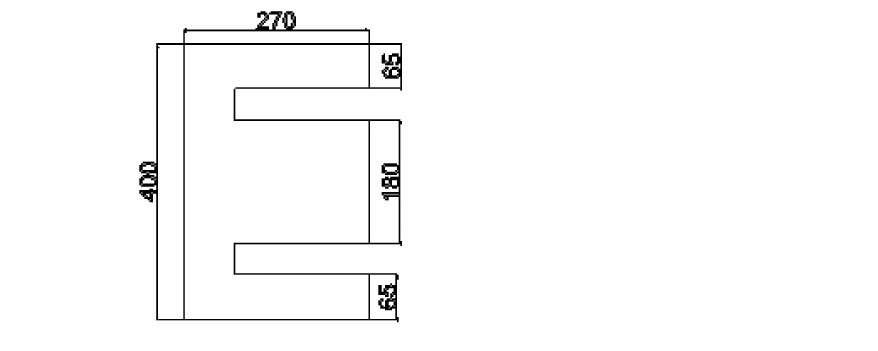
Figure 12. Horizontal loading steel plate for pushing (dimensions are in mm).